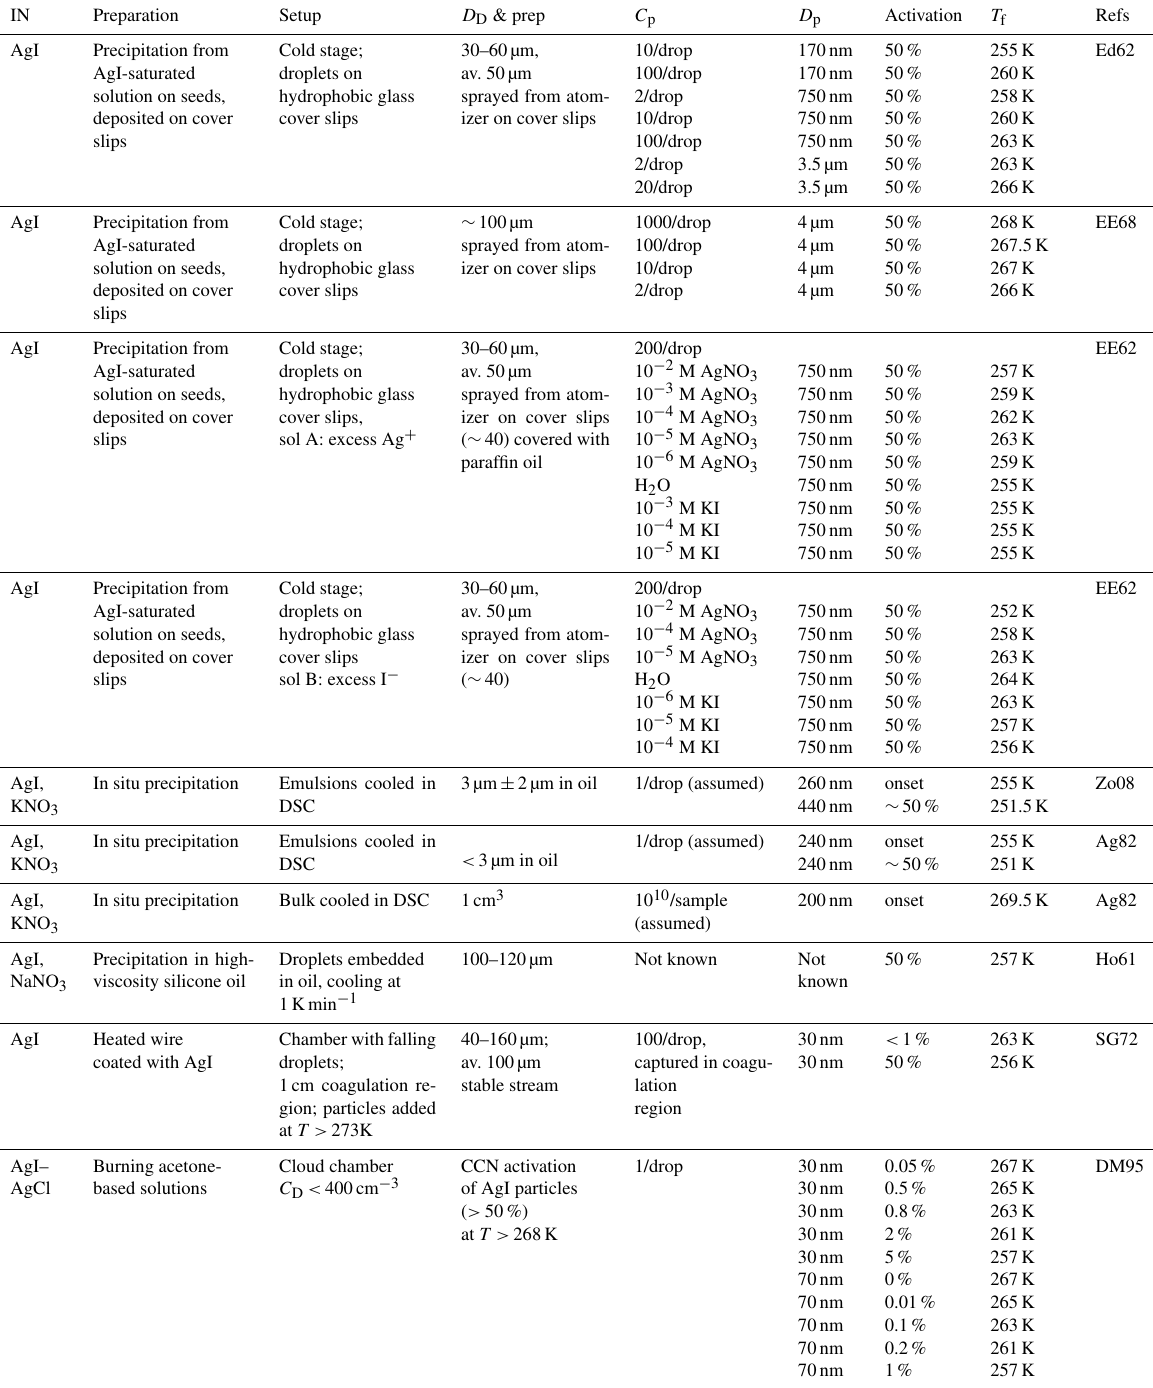
Table 1. Immersion freezing studies with AgI or related salts: IN – ice nuclei; D D – droplet diameter; C p – particle concentration; D p – particle diameter; T f – freezing temperature; C D – droplet concentration. References: Ed62 – Edwards et al. (1962); EE68 – Edwards and Evans (1968); EE62 – Edwards and Evans (1962); Zo08 – Zobrist et al. (2008); Ag82 – Aguerd et al. (1982); Ho61 – Hoffer (1961); SG72 – Sax and Goldsmith (1972); DM95 – DeMott (1995); VB84 – Vonnegut and Baldwin (1984); Pa86 – Palanisamy et al. (1986a); Da75 – Davis et al. (1975); DSC – differential scanning